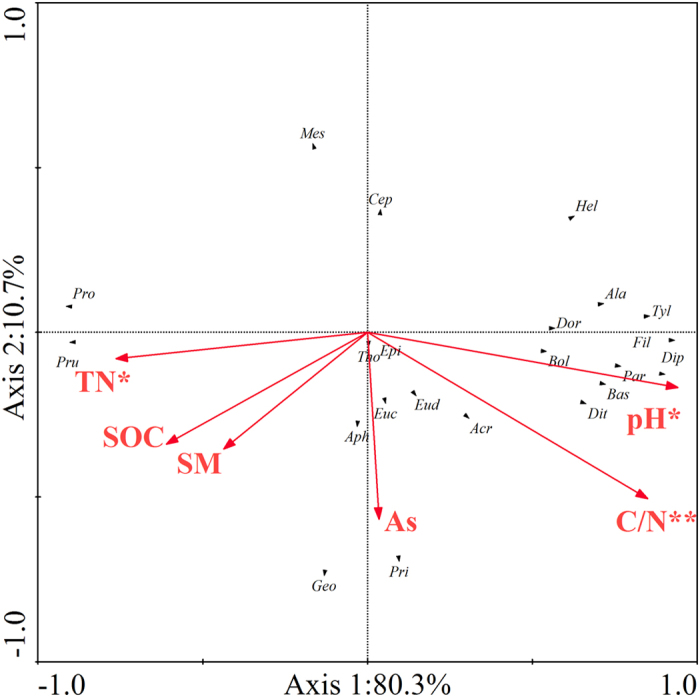
Redundancy analysis of the relationship between nematode genera and soil physiochemical properties in the wheat season.SOC, soil organic carbon; TN, total nitrogen; SM, soil moisture; As, aggregate size; C/N, C/N ratio; **P < 0.01; *P < 0.05. Mesorhabditis, Mes; Cephalobus, Cep; Eucephalobus, Euc; Acrobeloides, Acr; Prismatolaimus, Pri; Alaimus, Ala; Filenchus, Fil; Ditylenchus, Dit; Paraphelenchus, Par; Aphelenchoides, Aph; Diphtherophora, Dip; Tylencholaimus, Tyl; Thonus, Tho; Eudorylaimus, Eud; Epidorylaimus, Epi; Dorydorella, Dor; Boleodorus, Bol; Basiria, Bas; Geocenamus, Geo; Helicotylenchus, Hel; Pratylenchus, Pru; Pratylenchoides, Pro.